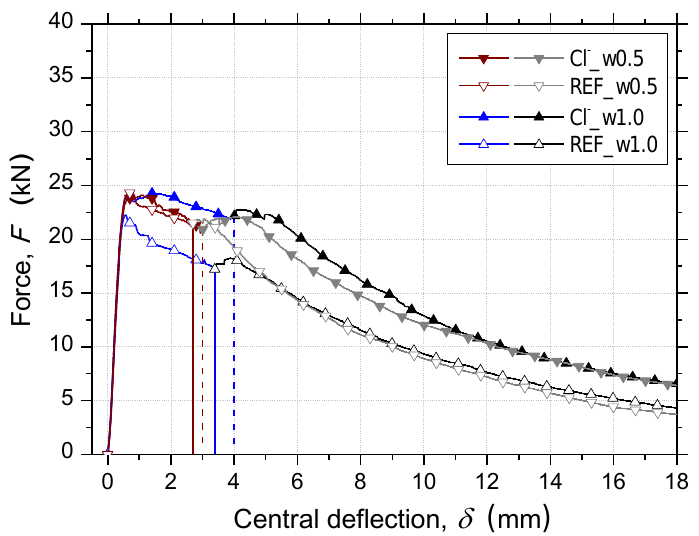
Figure 8. The average force–central deflection ( F − δ ) relationship for panels from RPT-3ps during the pre-cracking process and after the environmental exposure period of 90 days.